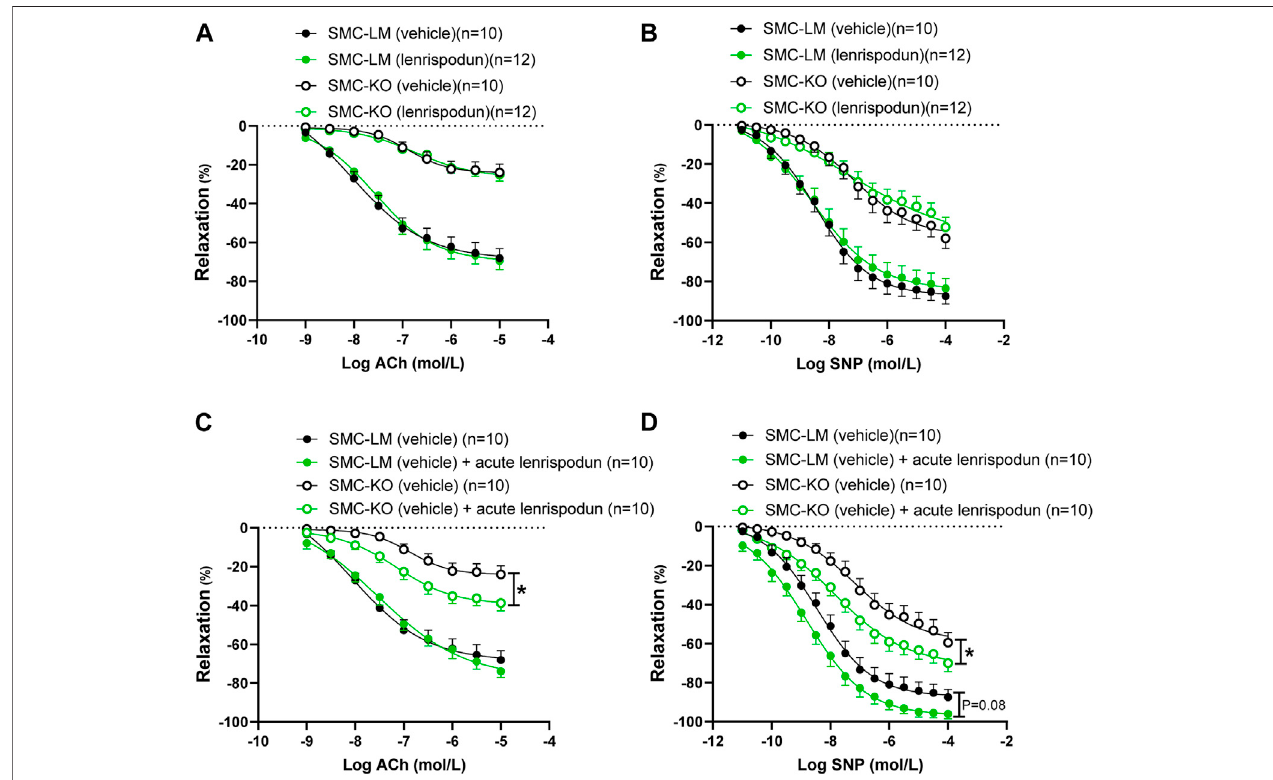
FIGURE 2 | Effect of chronic (A,B) and acute (C,D) lenrispodun treatment on endothelium-dependent (ACh) and -independent (SNP) responses in isolated aortic rings from SMC-KO mice (open circles) versusrings from SMC-LM ( fi lledcircles), lenrispodun-treated samples are shown in green. Relaxations are calculated relativeto the contraction produced by U46619 30 mmol/L in each ring, which are set at 100%. Values are expressed as means ± SEM; n, number of mice; *, p < 0.05, GLM for repeated